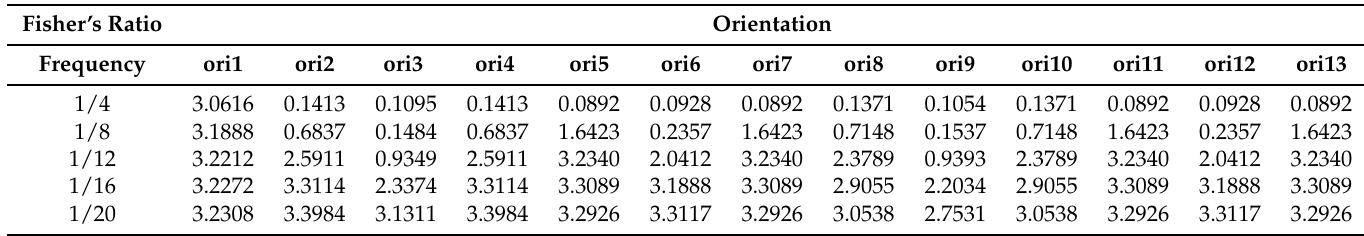
Table 1. FR value of 3D-Gabor cubes with different frequencies and orientations of Indian Pines dataset. “ori1” to “ori13” denote the 13 orientations constructed